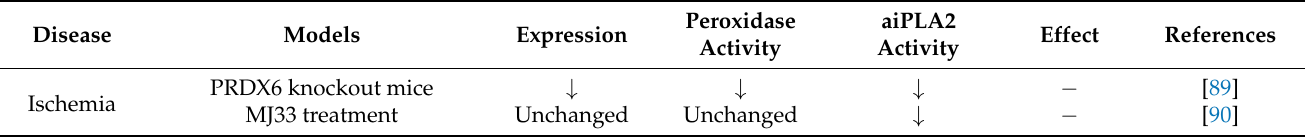
Table 4. PRDX6 expression and activity changes in LIRI